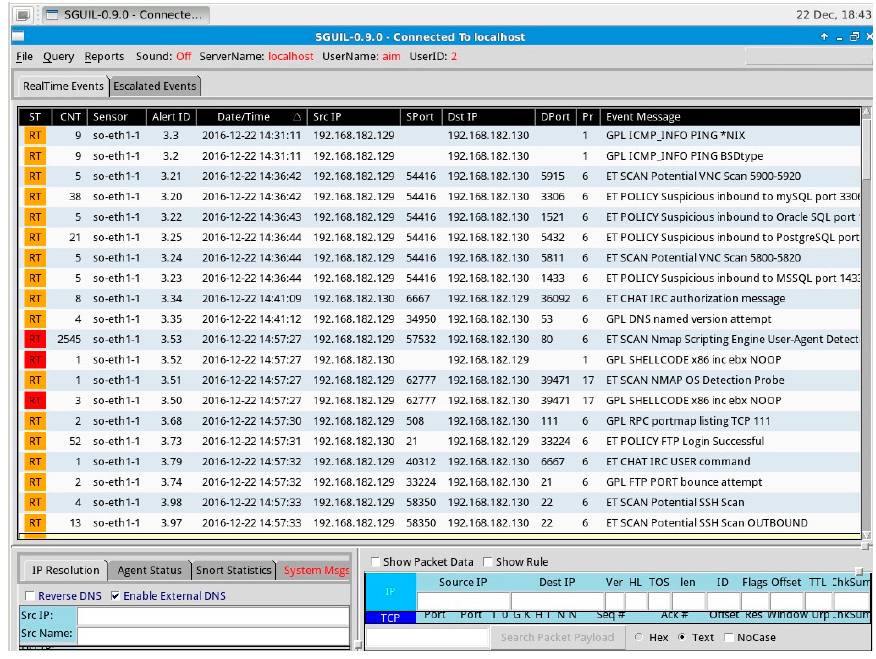
Figure 4. Sguil Console Output: Information Gathering.